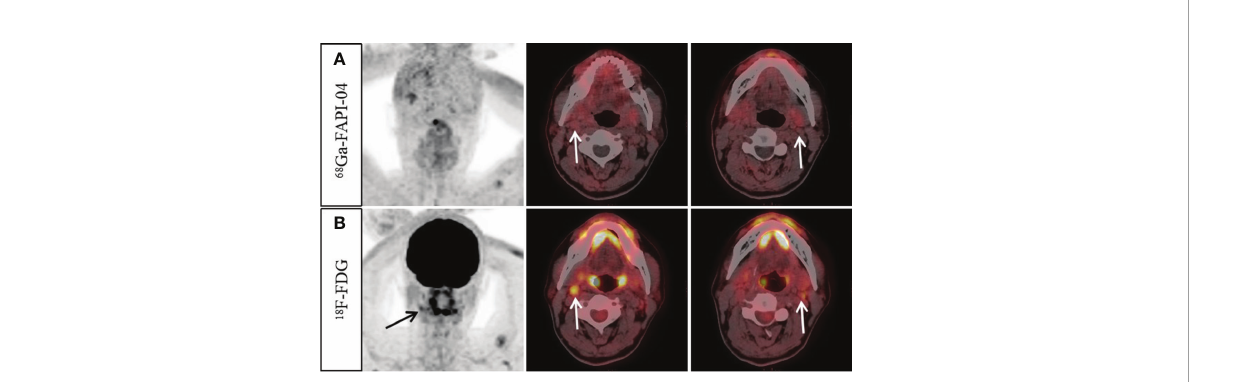
FIGURE 3 A 57-year-old man with nonkeratinizing undifferentiated carcinoma. An increase 18 F-FDG uptake was observed in the bilateral cervical (level II) lymph nodes ( B , arrow, SUVmax 3.3 – 4.2). However, no abnormal 68 Ga-FAPI-04 uptake was observed in the cervical lymph nodes ( A , arrow).